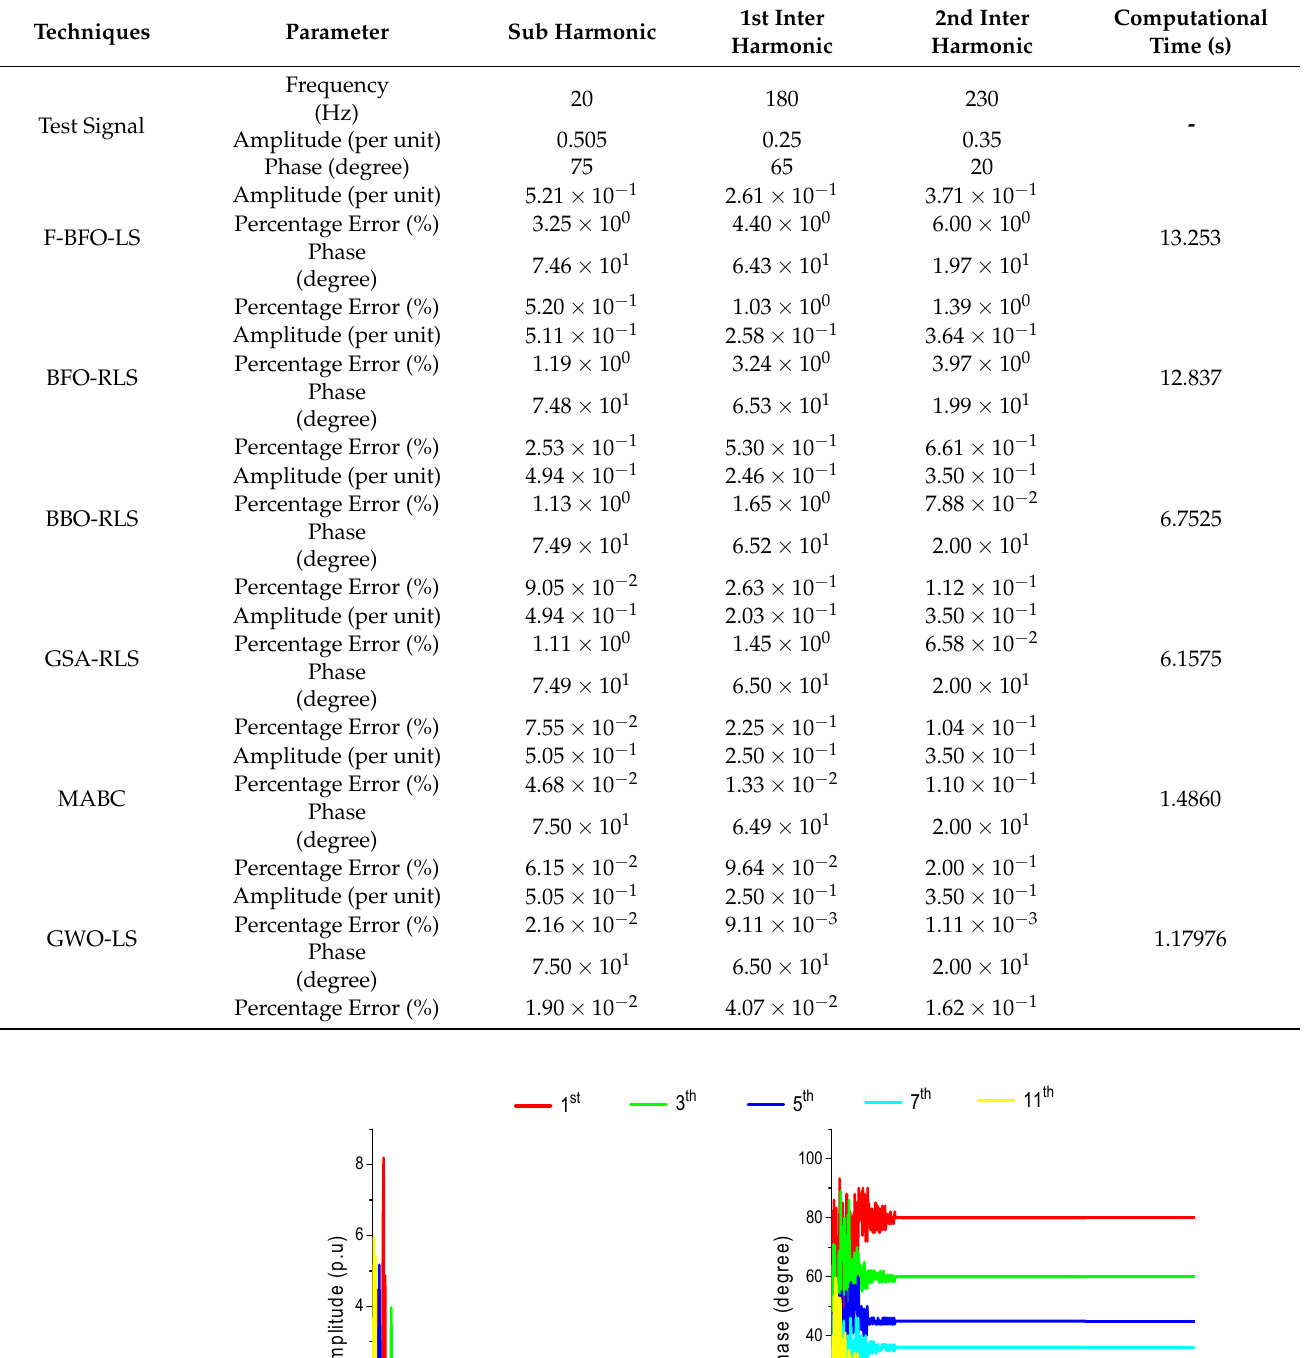
Table 6. GWO-LS Numerical Comparison for Case Study II.